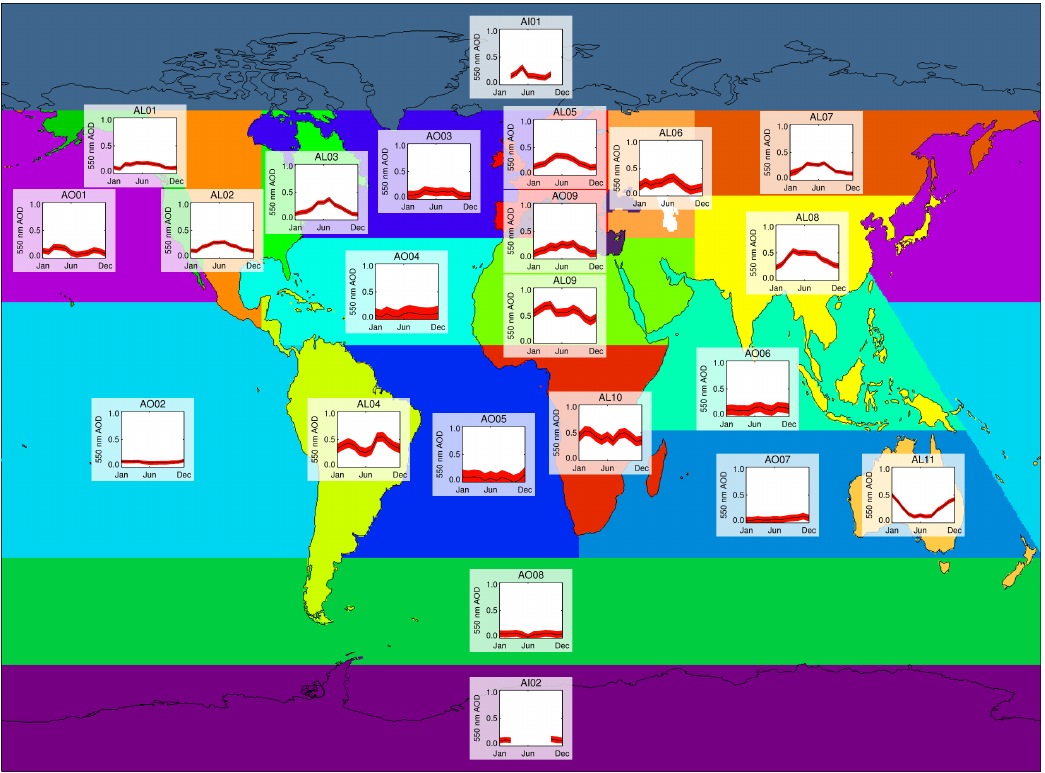
Fig. 2. Regional and monthly mean 550nm AOD for 2006 from the GlobAEROSOL AATSR dataset, corrected for regional biases against AERONET. The red shaded areas denote the ± 1 σ uncertainty, including the error against AERONET and sampling